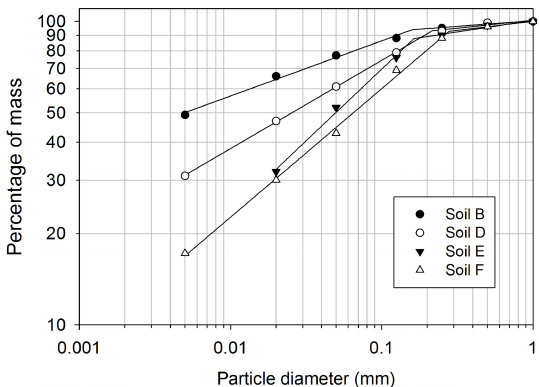
Figure 2. Scaling in cumulative particle mass of four soils studied by Tyler and Wheatcraft